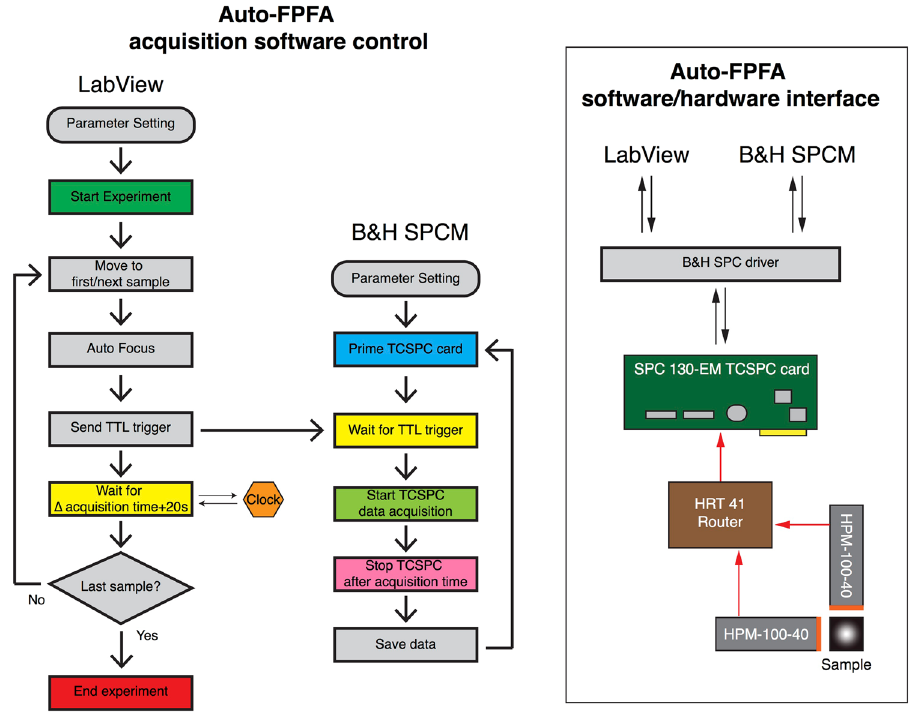
Figure 2. Auto-FPFA acquisition software control and software/hardware interface schematic. Left Panel: Diagram illustrates the Lab View control algorithm, and its integration with B&H SPCM software algorithm. LabView was used as the ‘master’ control data acquisition software, while B&H SPCM software was ‘slaved’ to it. LabView specifically controlled the XY-dual axis scanning stage controller that sequentially steps through the 96 samples in a micro-titer dish, as well as the Z-axis stage controller used for the auto-focus function. The ‘slaved’ B&H SPCM software was used to control the TCSPC SPC-130-EM card for data acquisition and data storage. Right Panel: Diagram illustrates the auto-FPFA software/hardware interface. The central component of this system is the B&H SPC 130-EM TCSPC card. Both LabView and B&H SPCM software communicate (send commands and receive data) with the TCSPC card via a B&H SPC driver. Once activated, the TCSPC card receives data from the two HPM-100-40 hybrid photon detectors via a HRT 41 multiplexing router. The TCSPC card also receives laser pulse timing data from a photo-diode detector (not shown, but see Fig.